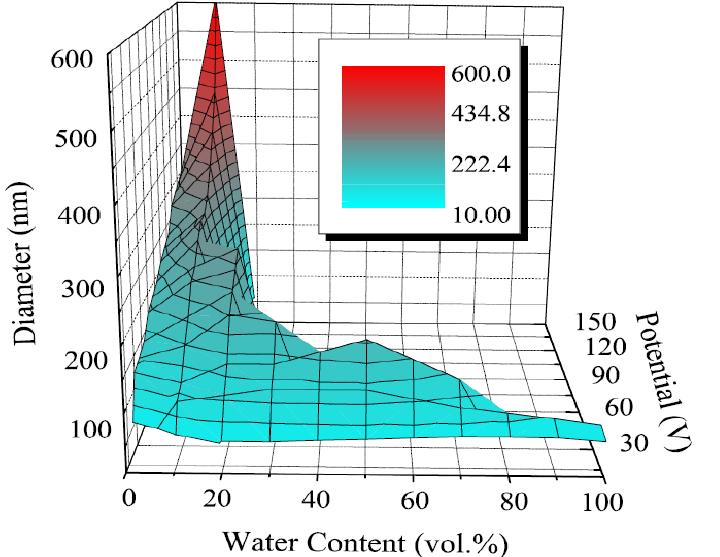
Figure 8. Effect of water content and voltage on the nanotube diameter. Water content under 20% increases the nanotube diameter while limiting the voltage at which nanotubes are formed. Reprinted with permission from [38]. Copyright 2010 IOP